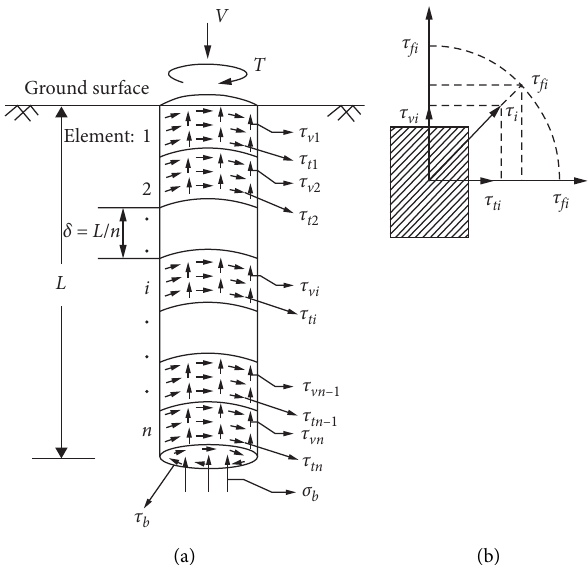
Figure 1: Shear effect of the soil around the pile shaft. (a) Discrete diagram of a single pile. (b) Shear element